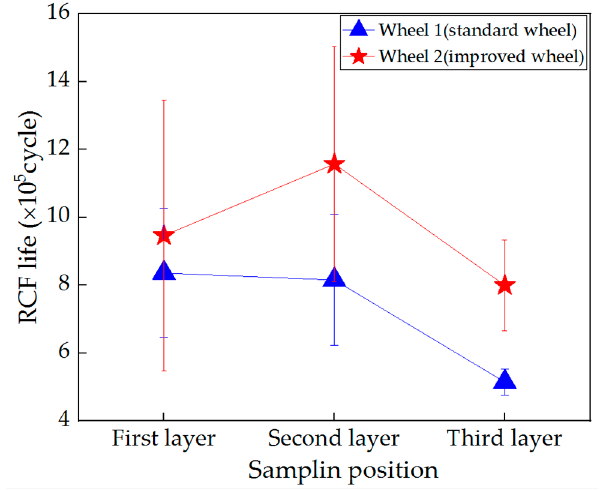
Figure 5. Rolling contact fatigue lives of the wheel rollers